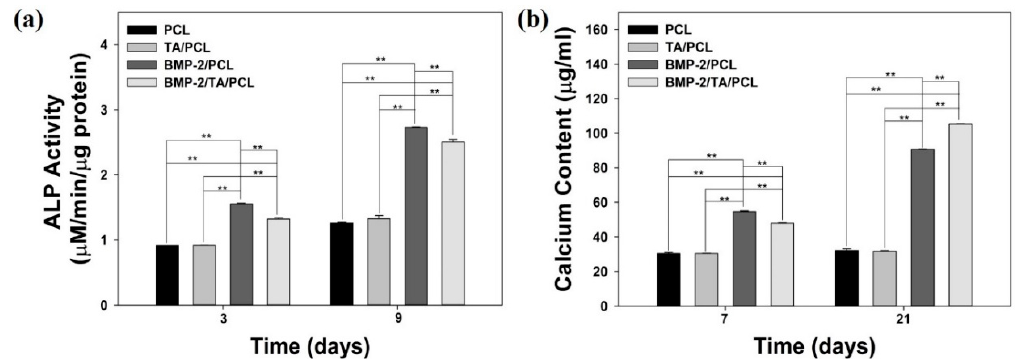
Figure 8. ( a ) Alkaline phosphatase (ALP) activity and ( b ) calcium deposition of MC3T3-E1 cells cultured on PCL, TA/PCL, BMP-2/PCL, and BMP-2/TA/PCL scaffolds. Error bars represent the mean ± SD. ** p < 0.01.